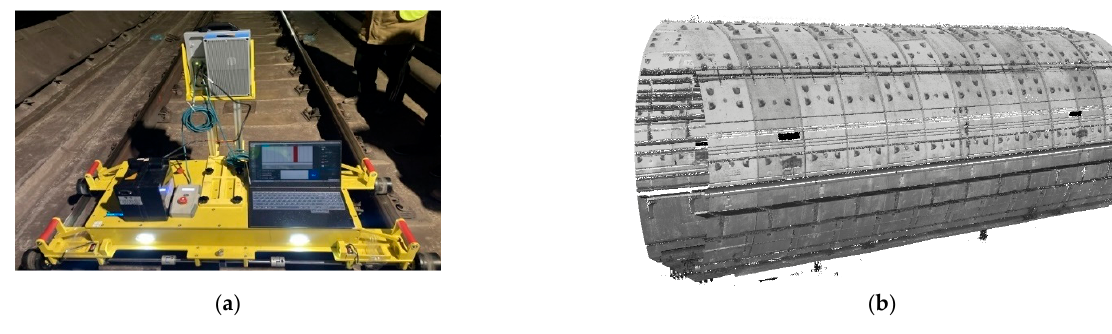
Table 2. Z+F 9012 laser scanner parameters.